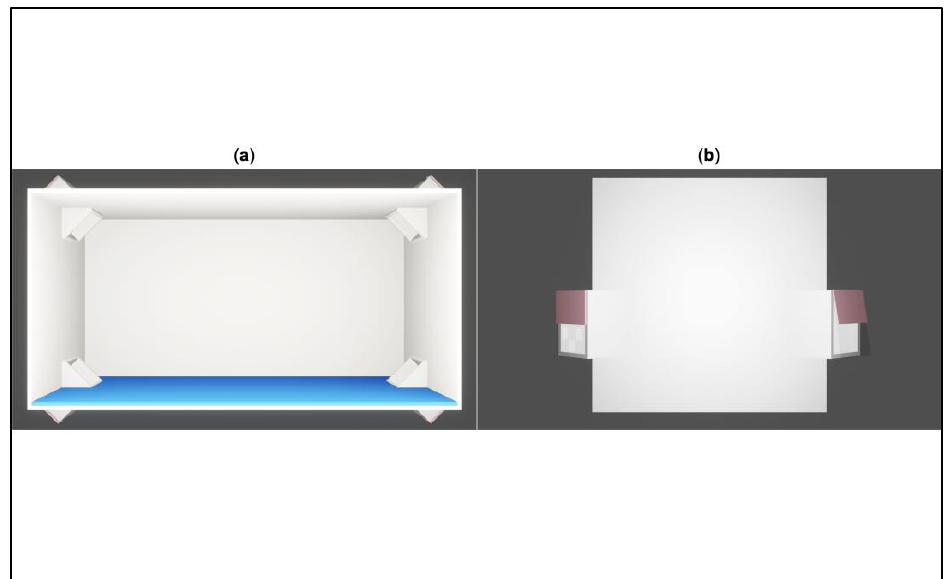
Figure 1. 3D reconstruction of the testing arena with the conspicuous landmark. ( a ) Top view of the rectangular white arena with the blue wall (long version). ( b ) Frontal view of the arena, with a detail on the corridors. Credit by Greta Baratti.